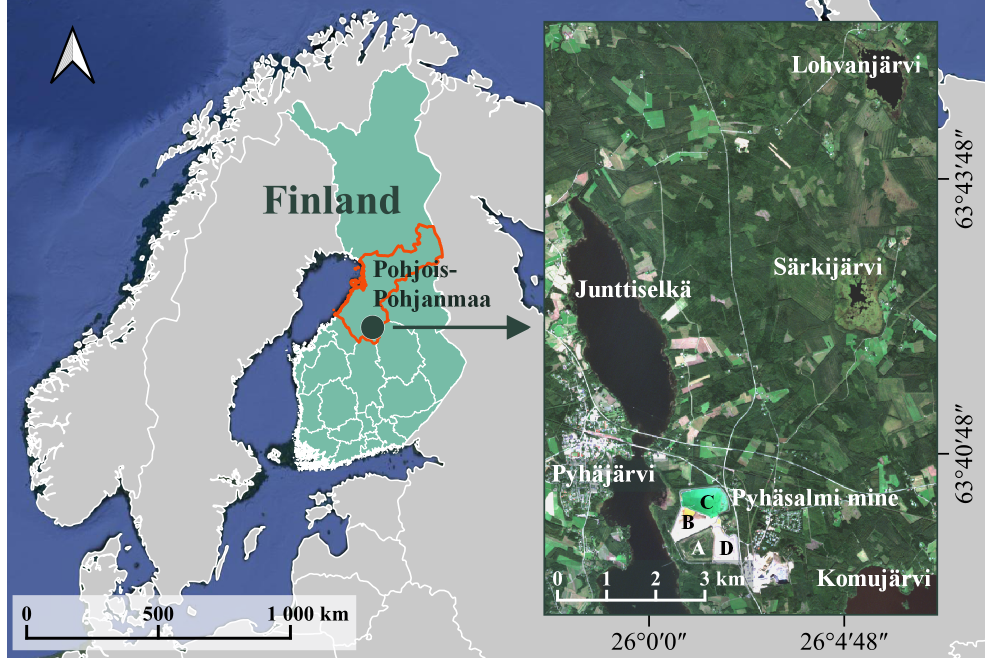
Figure 1. Study area in Pohjois-Pohjanmaa region (Finland). Basemap: Google Earth Satellite (EPSG:4326–WGS